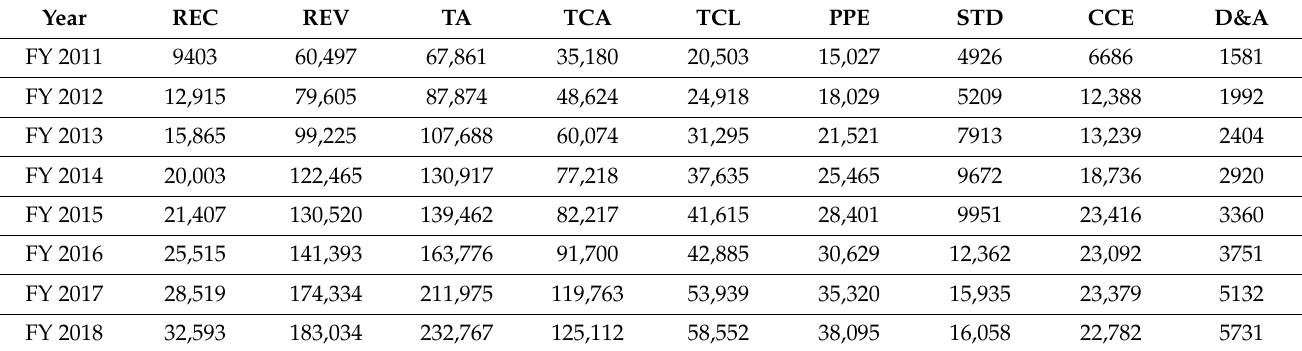
Table 3. Year wise summary statistics of all variables across all industries (in million